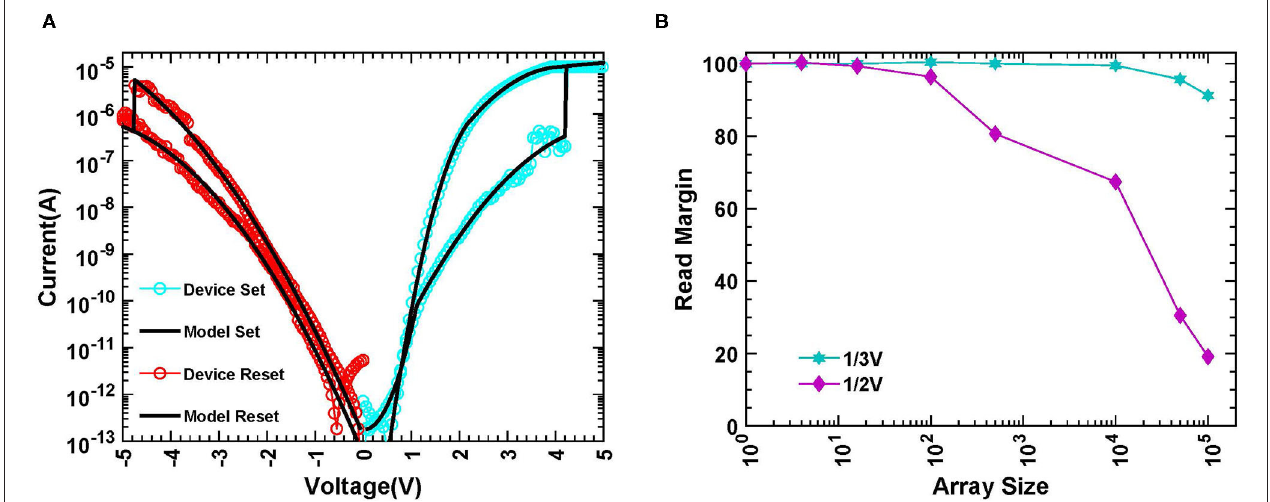
FIGURE 6 | Circuit level modeling of 1S1R based CBA. (A) SPICE simulation of single device IV sweep (solid line), (B) Normalize Readout Margin for different array sizes. TE, ME, and BE are marked on the figure.